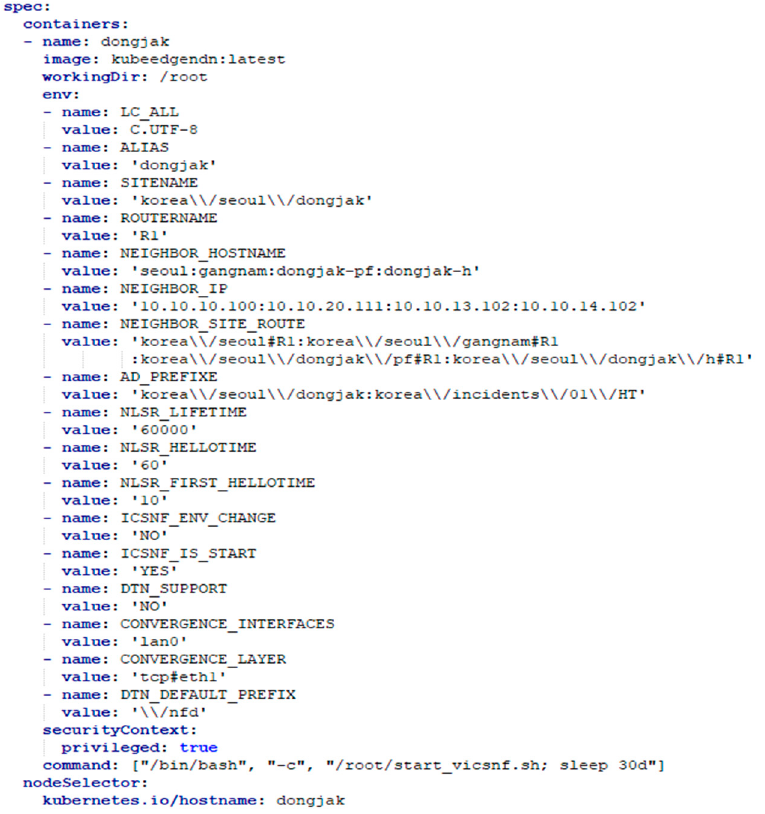
Figure 10. NDN containerized router deployment file example.